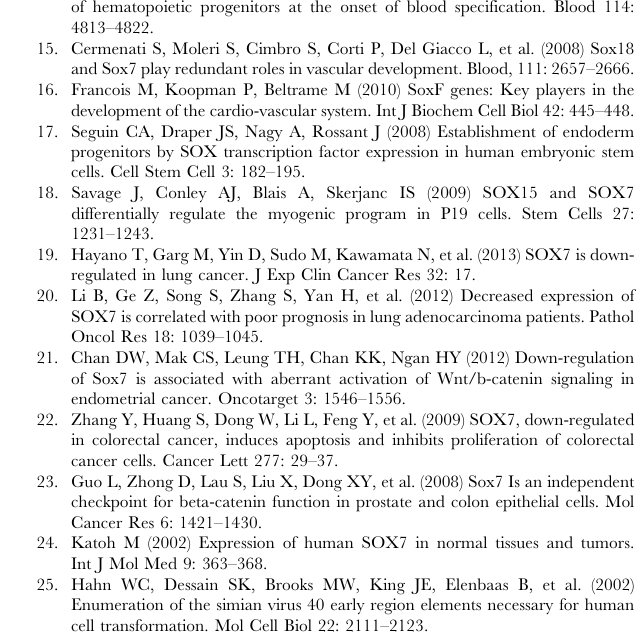
Figure S5 HCC proliferation is markedly promoted by miR-184 inhibition and SOX7 upregulation. A . The expression levels of SOX7 in miR-184-inhibitor transfected HCC cells that overexpressing SOX7, as measured by western blotting; a -Tubulin served as the loading control. B . The growth rates in miR-184-inhibited and SOX7-overexpressing cells, as indicated by the MTT assay. C . Quantifications of crystal violet stained cell colonies formed by indicated HCC cell lines, 10 days after inoculation. D . Quantifications of colony numbers of indicated cells determined by an anchorage-independent growth assay. Colonies larger than 0.1 mm in diameter were scored. Error bars represent the mean 6 SD from three independent experiments. * P ,